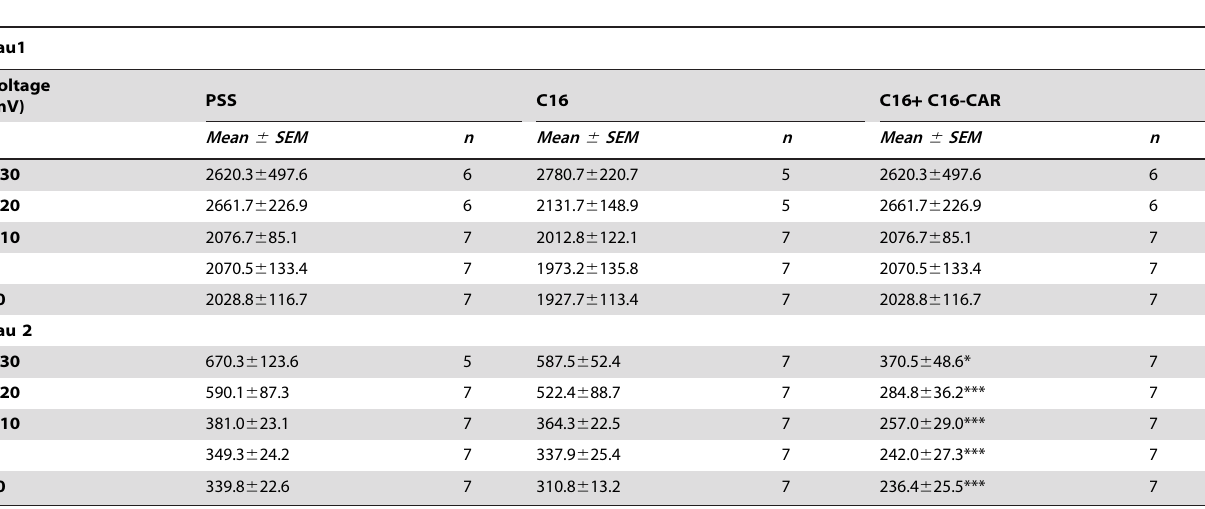
Table 3. Effect of extracellular C16 free fatty acid either alone or in combination with C16-CAR on I hERG deactivation time